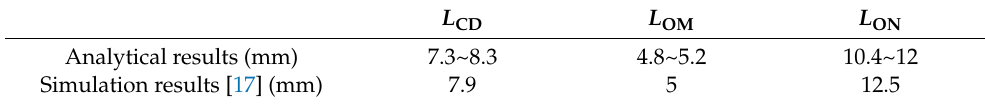
Table 8. Comparison of analytical and simulation results in